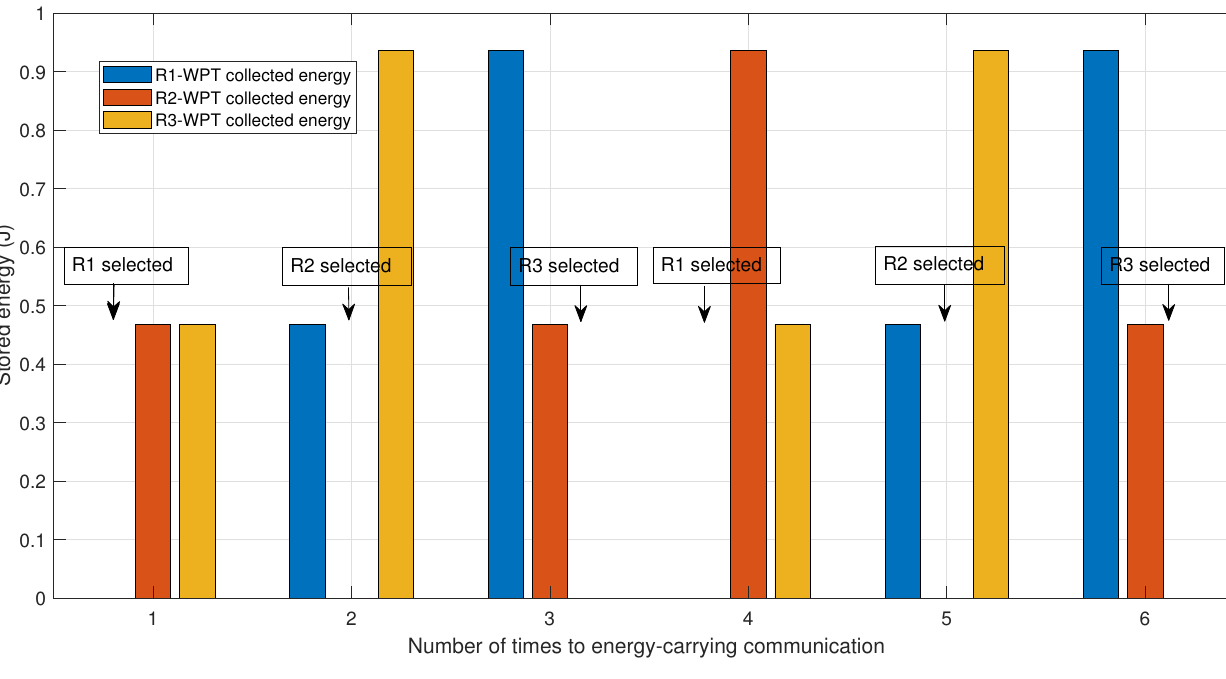
Figure 11. Energy collected by different relay nodes through